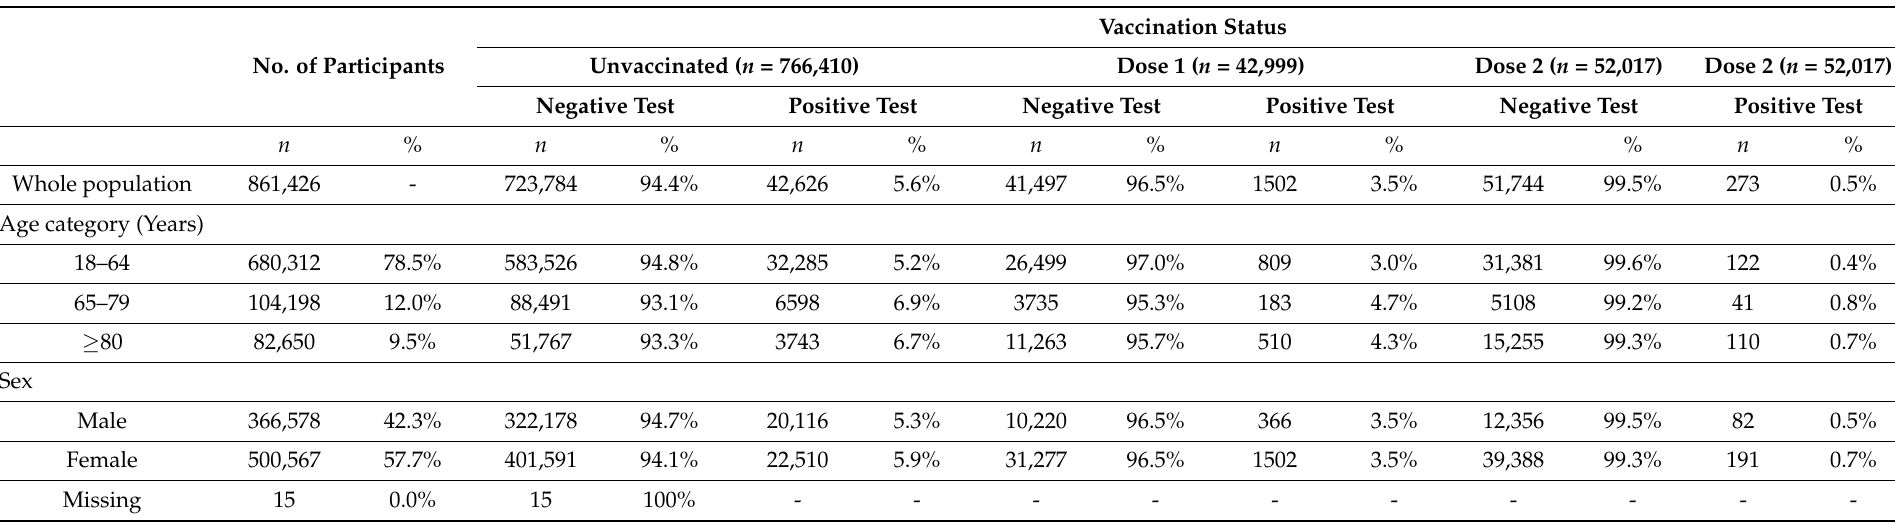
Table 1. Description of included SARS-CoV-2 tests stratifying by age, sex, vaccination status and test